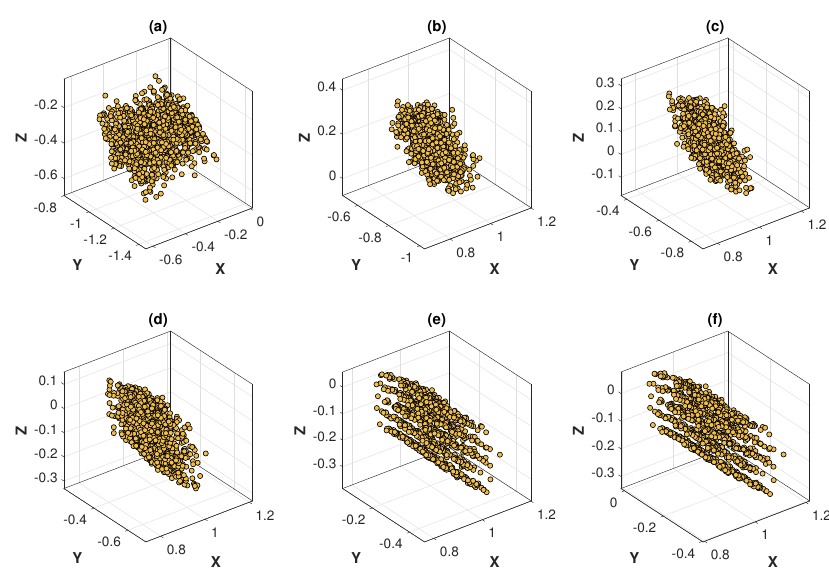
Figure 14. Optimization process of the MinVar method with feature noise [0–1.5 pixel]: ( a ) 3D points at iteration 1; ( b ) 3D points at iteration 3; ( c ) 3D points at iteration 5; ( d ) 3D points at iteration 7; ( e ) 3D points at iteration 10; ( f ) 3D points at iteration 15 (converged).